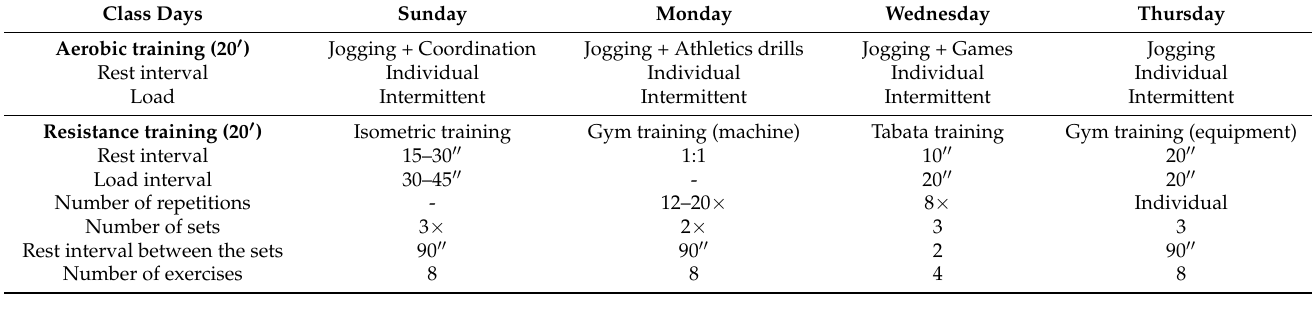
Table 1. Training protocol for aerobic and resistance training program.